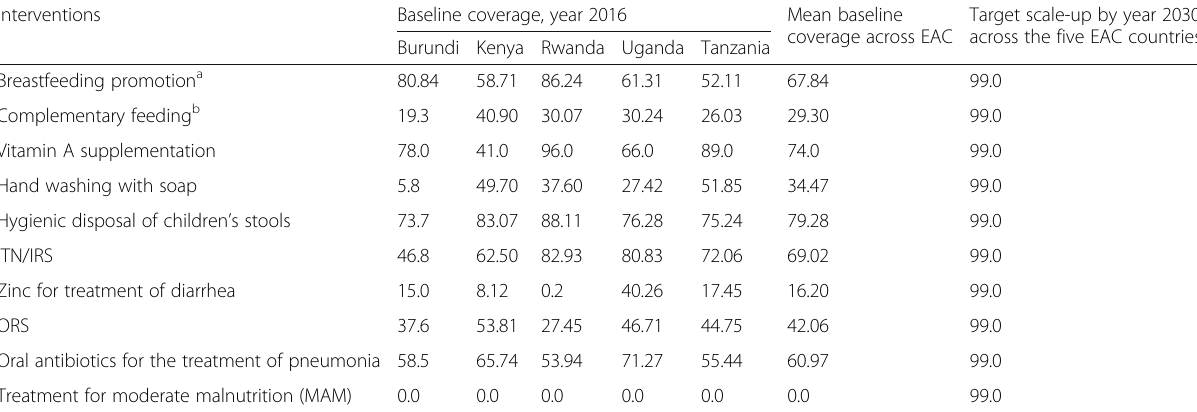
Table 3 Baseline coverage and percent scale-up for community level interventions across EAC